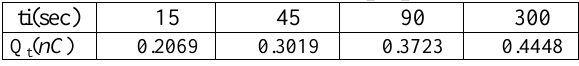
Table-I: Trapped charges as a function of irradiation time see reference